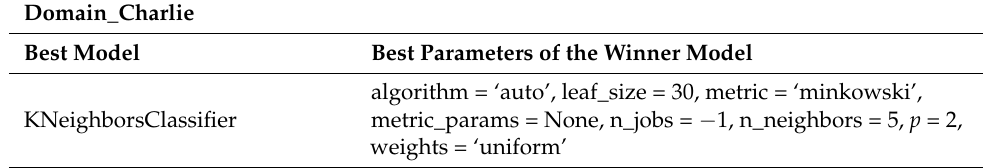
Table 6. Best parameters of the winner model of the Domain Charlie.